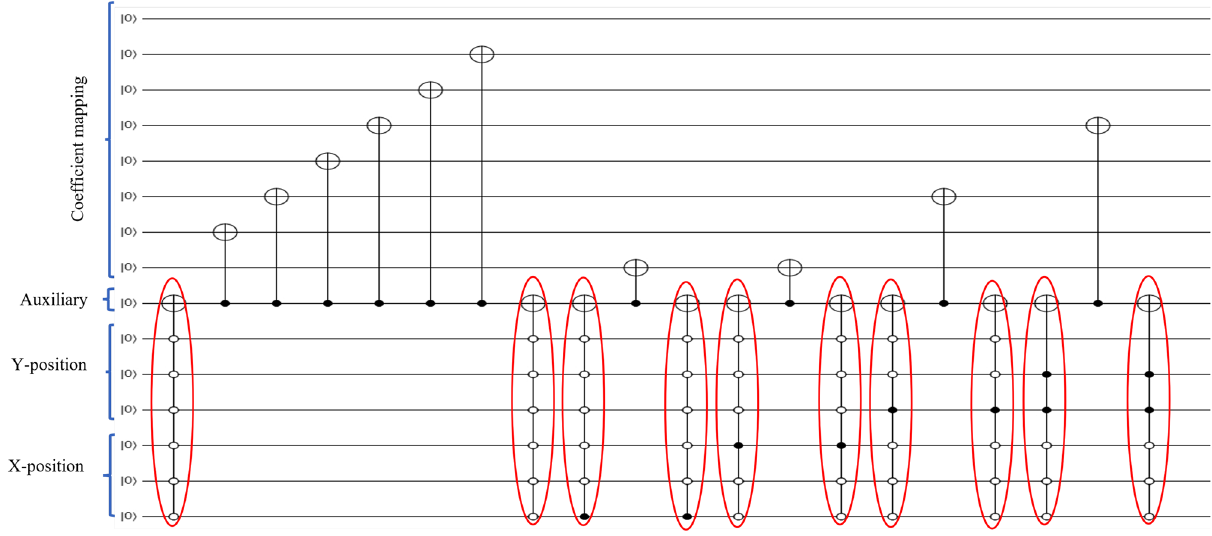
8 DCT-EFRQI quantum image and its quantum Figure 5. A 8 ×